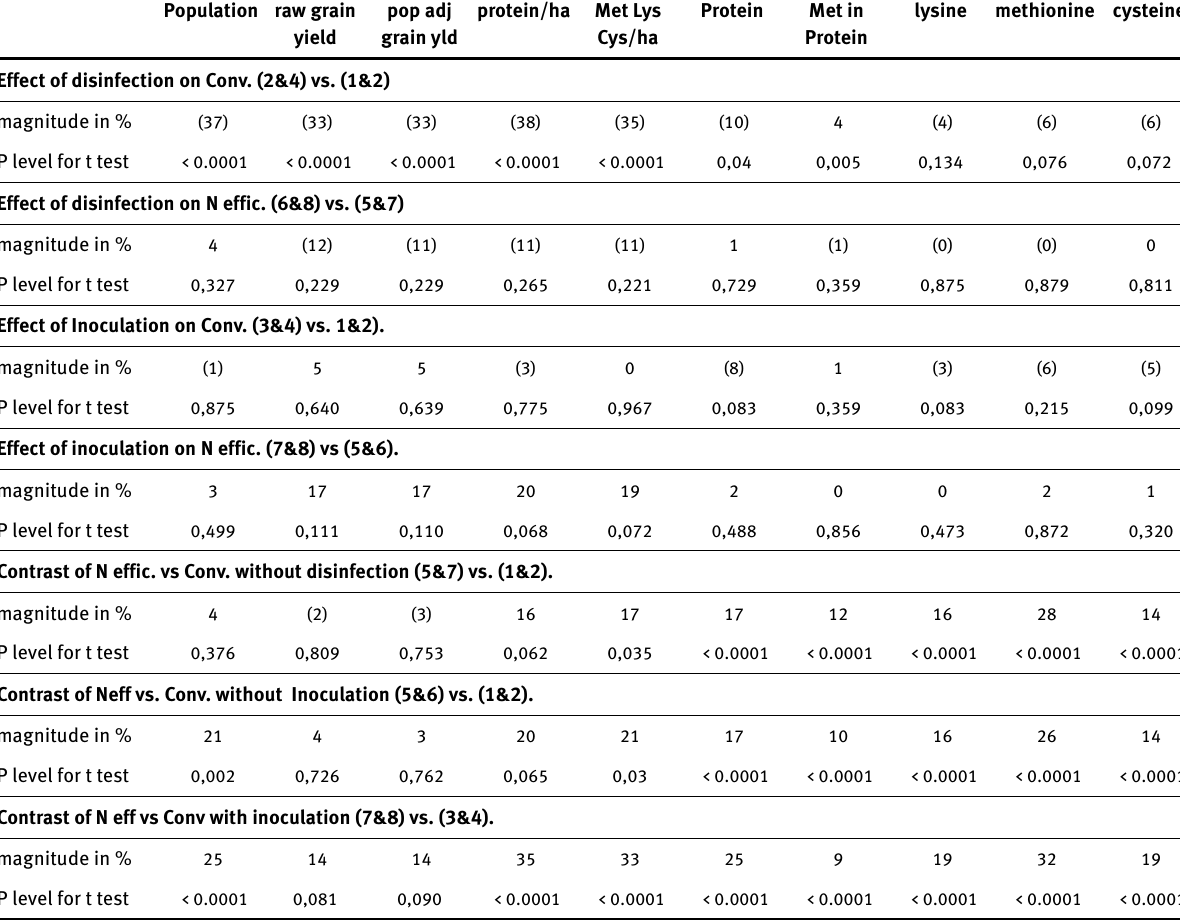
Table 5. Orthogonal contrasts for disinfection or inoculation treatments for conventional and N efficient hybrids including magnitude of response and level of